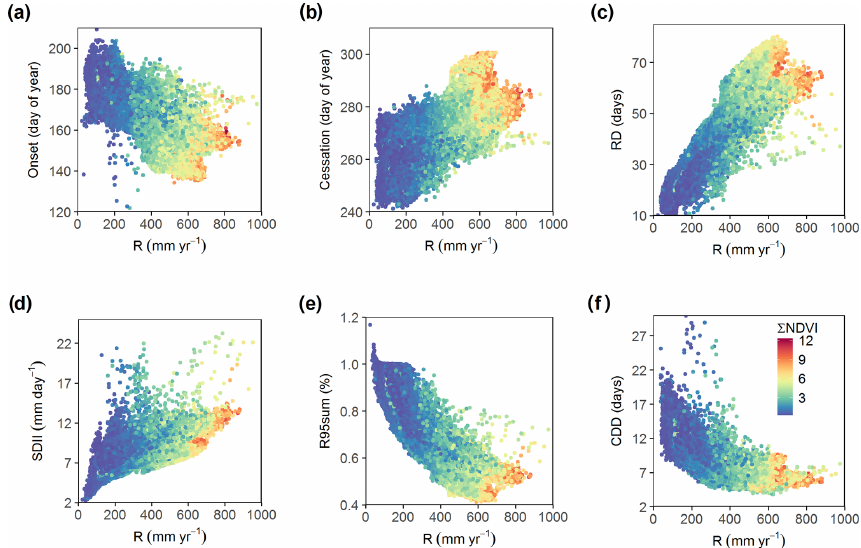
Figure 6. Relationships between seasonal-rainfall metrics and growing season ANPP as a function of seasonal rainfall amount based on 15-year averages